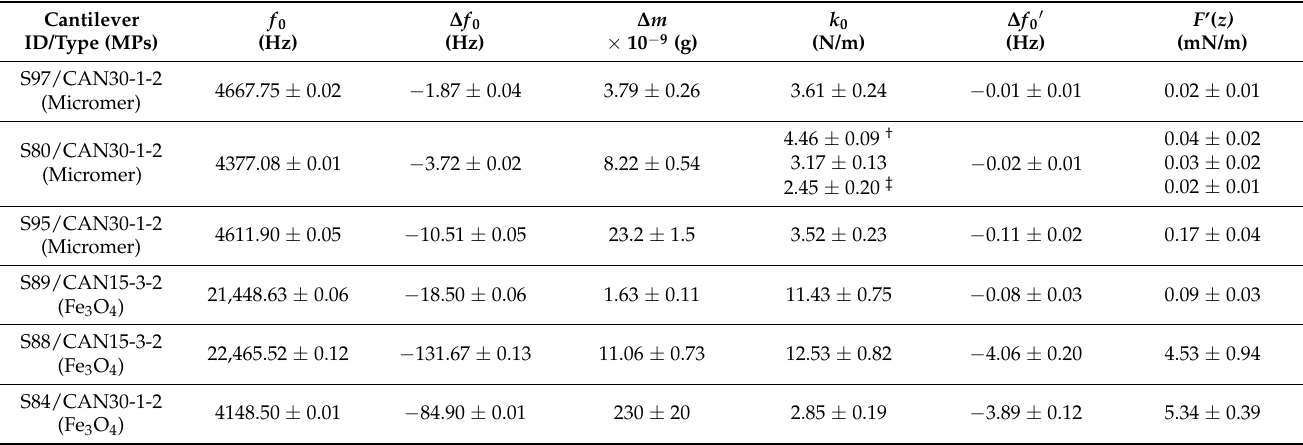
Table 3. Magnetic force gradient under 2 mm magnets spacing (with δ 2 B / δ z 2 | max ≈ 1.57 T/mm 2 ) from assorted cantilever sensors with different resonance attributes and attached particle